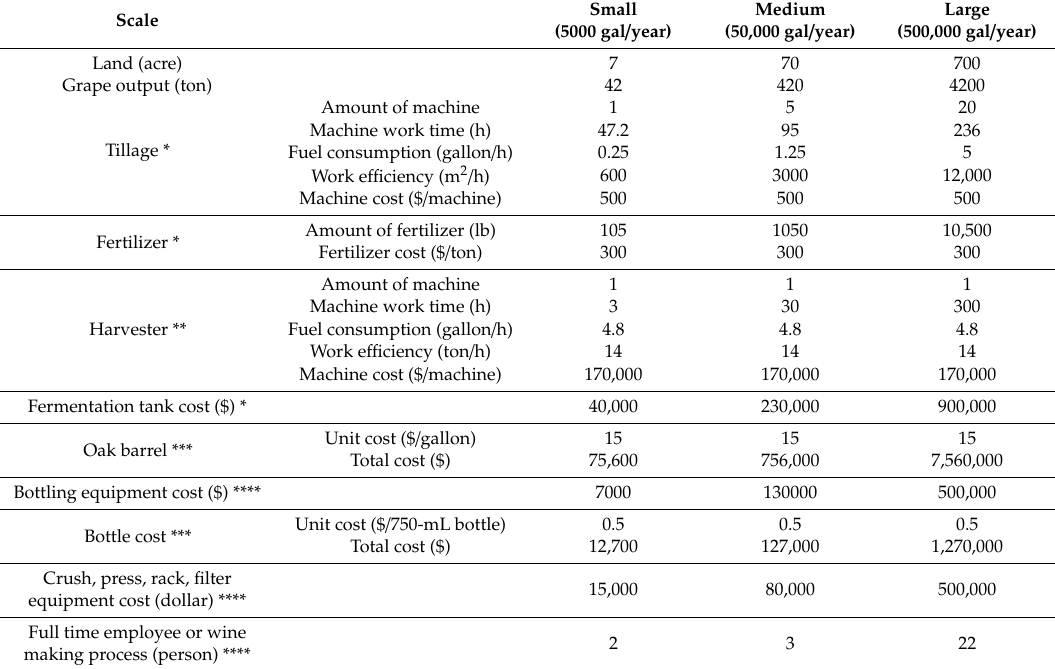
Table 4. Data inventory used for techno-economic analysis of various production scales 1